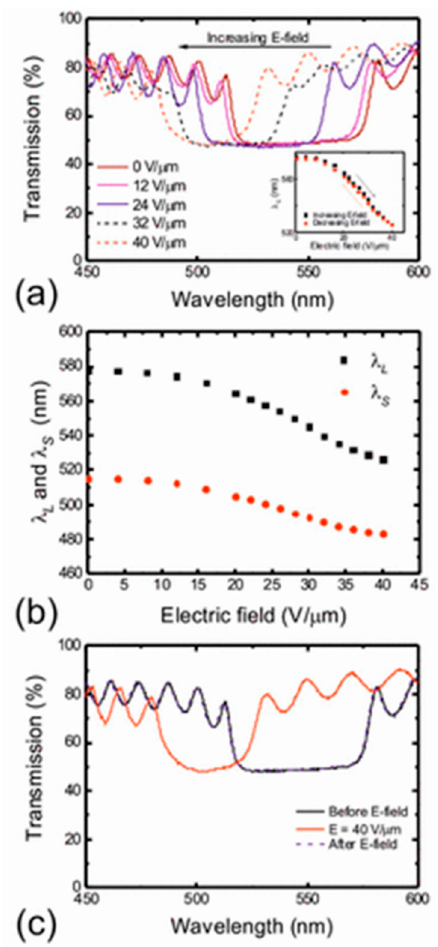
Figure 11. ( a ) Plot of the transmission spectrum for the di ff erent amplitudes of the applied electric field (inset: a plot of the long-wavelength band-edge upon increasing and decreasing the applied electric field). ( b ) Plots of both the long- and short-wavelength band-edges as a function of the applied electric field amplitude. λ L and λ S are the wavelength position of the long and short band-edge of the reflection band. ( c ) Transmission spectra before, during, and after the application of an electric field. Reprinted with permission from Wood et al., Macromolecules 2016 , 49 , 8643–8652.